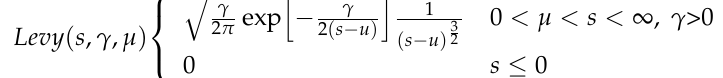
Figure 2. L é vy flight simulation Figure 2. Lévy flight simulation diagram.